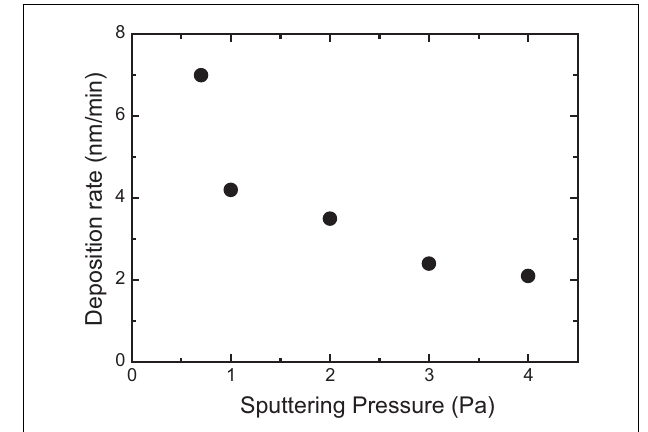
FIGURE 1 |Variation of the deposition rate ofTiO 2 films as a function of the sputtering pressure